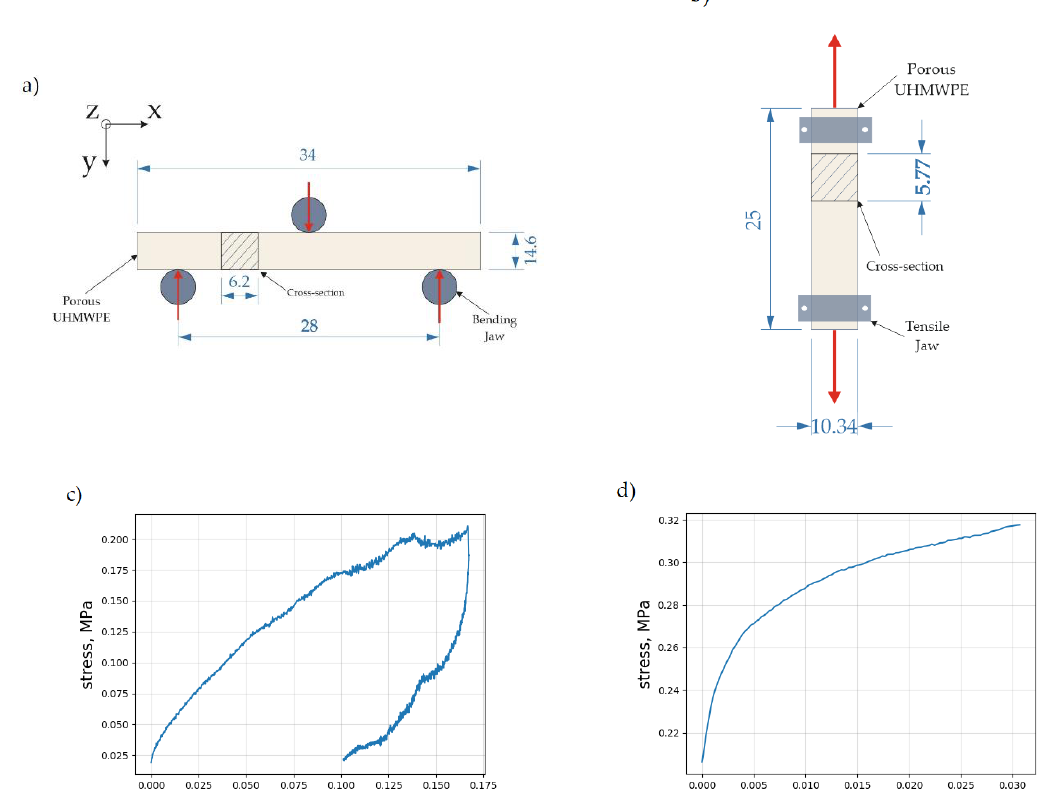
Figure 2. The schematic illustration of the three-point bending experiment ( a ) and tensile testing ( b ) Dimensions in millimeters. The stress–strain curves recorded during the three-point bending load application ( c ) and tensile testing ( d ), respectively.